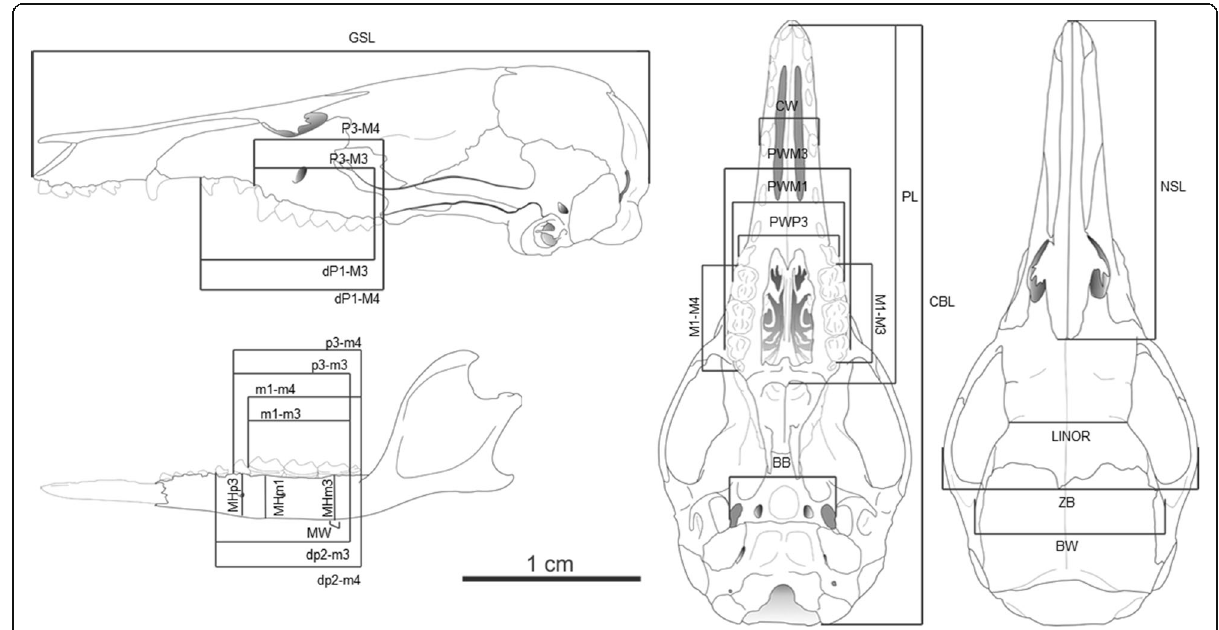
Fig. 1 Line drawings of the crania and mandible of Rhyncholestes raphanurus Osgood based on specimen UACH 2244 ♂ , indicating the measurements taken: greatest skull length (GSL); zygomatic breadth (ZB); palatine length (PL); palate width at canines (CW); palate width at P3 (PWP3); palate width at M1 (PWM1); palate width at M3 (PWM3); interorbital constriction (LINOR); nasal length (NSL); braincase width (BW); condylobasal length (CBL); distance between bullae (BB); mandibular width (MW); mandibular height at p3 (MHp3); mandibular height at m1 (MHm1); mandibular height at m3 (MHm3); length from the anteriormost point of the first upper premolar to the posteriormost point of the last upper molar (dP1-M4); length from the anteriormost point of the first upper premolar to the posteriormost point of the third upper molar (dP1- M3); length from the anteriormost point of the third upper premolar to the posteriormost point of the last upper molar (P3-M4); length from the anteriormost point of the third upper premolar to the posteriormost point of the third upper molar (P3-M3); length from the anteriormost point of the first lower premolar to the posteriormost point of the last lower molar (dp1-m4); length from the anteriormost point of the first lower premolar to the posteriormost point of the third lower molar (dp1-m3); length from the anteriormost point of the second lower premolar to the posteriormost point of the last lower molar (dp2-m4); length from the anteriormost point of the second lower premolar to the posteriormost point of the third lower molar (dp2-m3); length from the anteriormost point of the third lower premolar to the posteriormost point of the last lower molar (p3-m4); length from the anteriormost point of the third lower premolar to the posteriormost point of the third lower molar (p3-m3); length from the anteriormost point of the first lower molar to the posteriormost point of the third lower molar (m1-m3); length from the anteriormost point of the first lower molar to the posteriormost point of the last lower molar